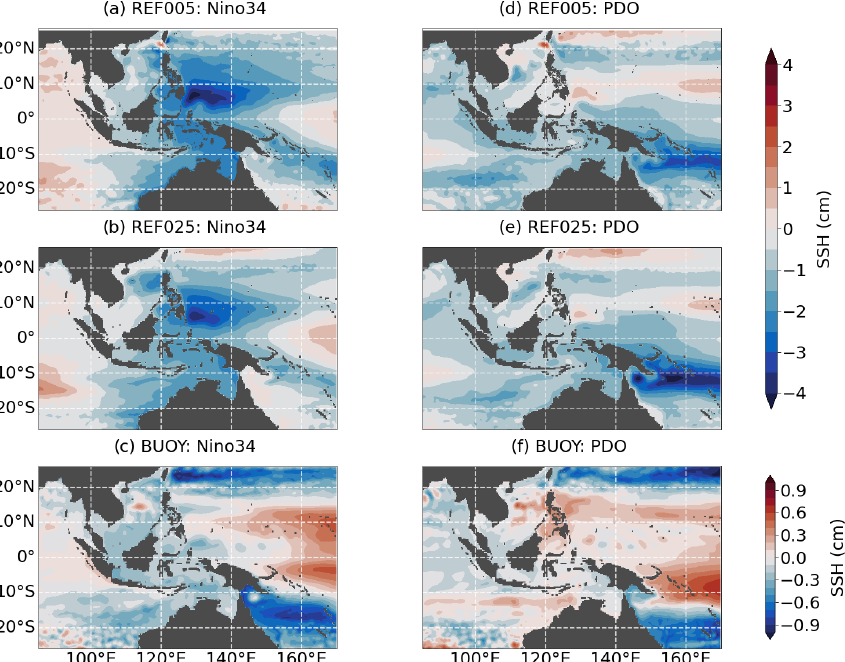
Figure 5. Linear regression of SSH with the (a–c) Niño3.4 index and (d–f) PDO index for two hindcast (REF025, REF005) and buoyancy forcing experiments (BUOY). Climate indices are derived from the base model in the case of REF005 and from REF025 for the other two experiments. All data have been filtered with an 8-year low-pass filter. Note the different colour bars.